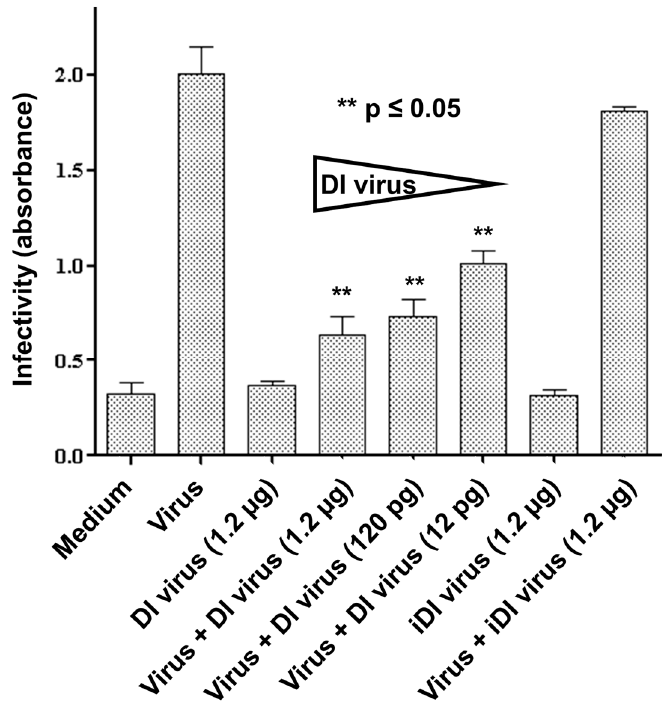
Figure 2. The 244/PR8 DI virus interferes with the multiplication of infectious influenza A/WSN/33 in primary human nasal basal cells. Basal cells were inoculated with 12 pg, 120 pg or 1.2 µ g DI virus or 1.2 µ g inactivated DI virus (iDI) before infection with influenza A/WSN/33 virus. Culture supernatants were collected and assayed for virus infectivity after 24 h. Infectivity was significantly reduced at all concentrations of DI virus employed (** p ≤ 0.05).